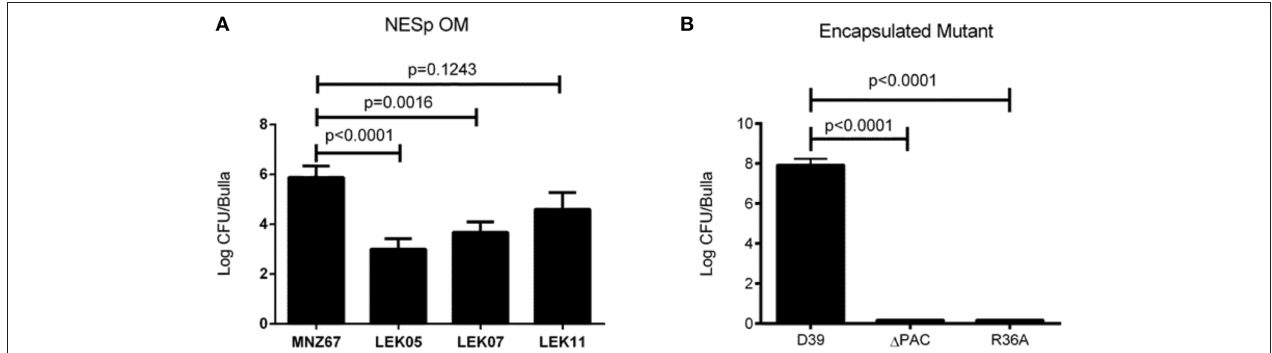
FIGURE 1 | Deletion of pneumococcal virulence factors significantly reduces bacterial burden during experimental OM. (A) Single gene deletion of pspK (LEK05; p < 0.0001) or ply (LEK07; p = 0.0016) and double gene deletions of pspK and ply (LEK11; p = 0.1243) had significant reductions in recovered bacteria compared to wildtype NESp MNZ67. (B) Serotype 2 pneumococcal strain D39 had high levels of bacteria recovered from the middle ear of chinchillas, but no bacteria were recovered when chinchillas were challenged with a D39 triple gene deletion mutant 1 PAC or acapsulalar mutant R36A ( p < 0.0001). Data represents at least two independent experiments of four bullae per